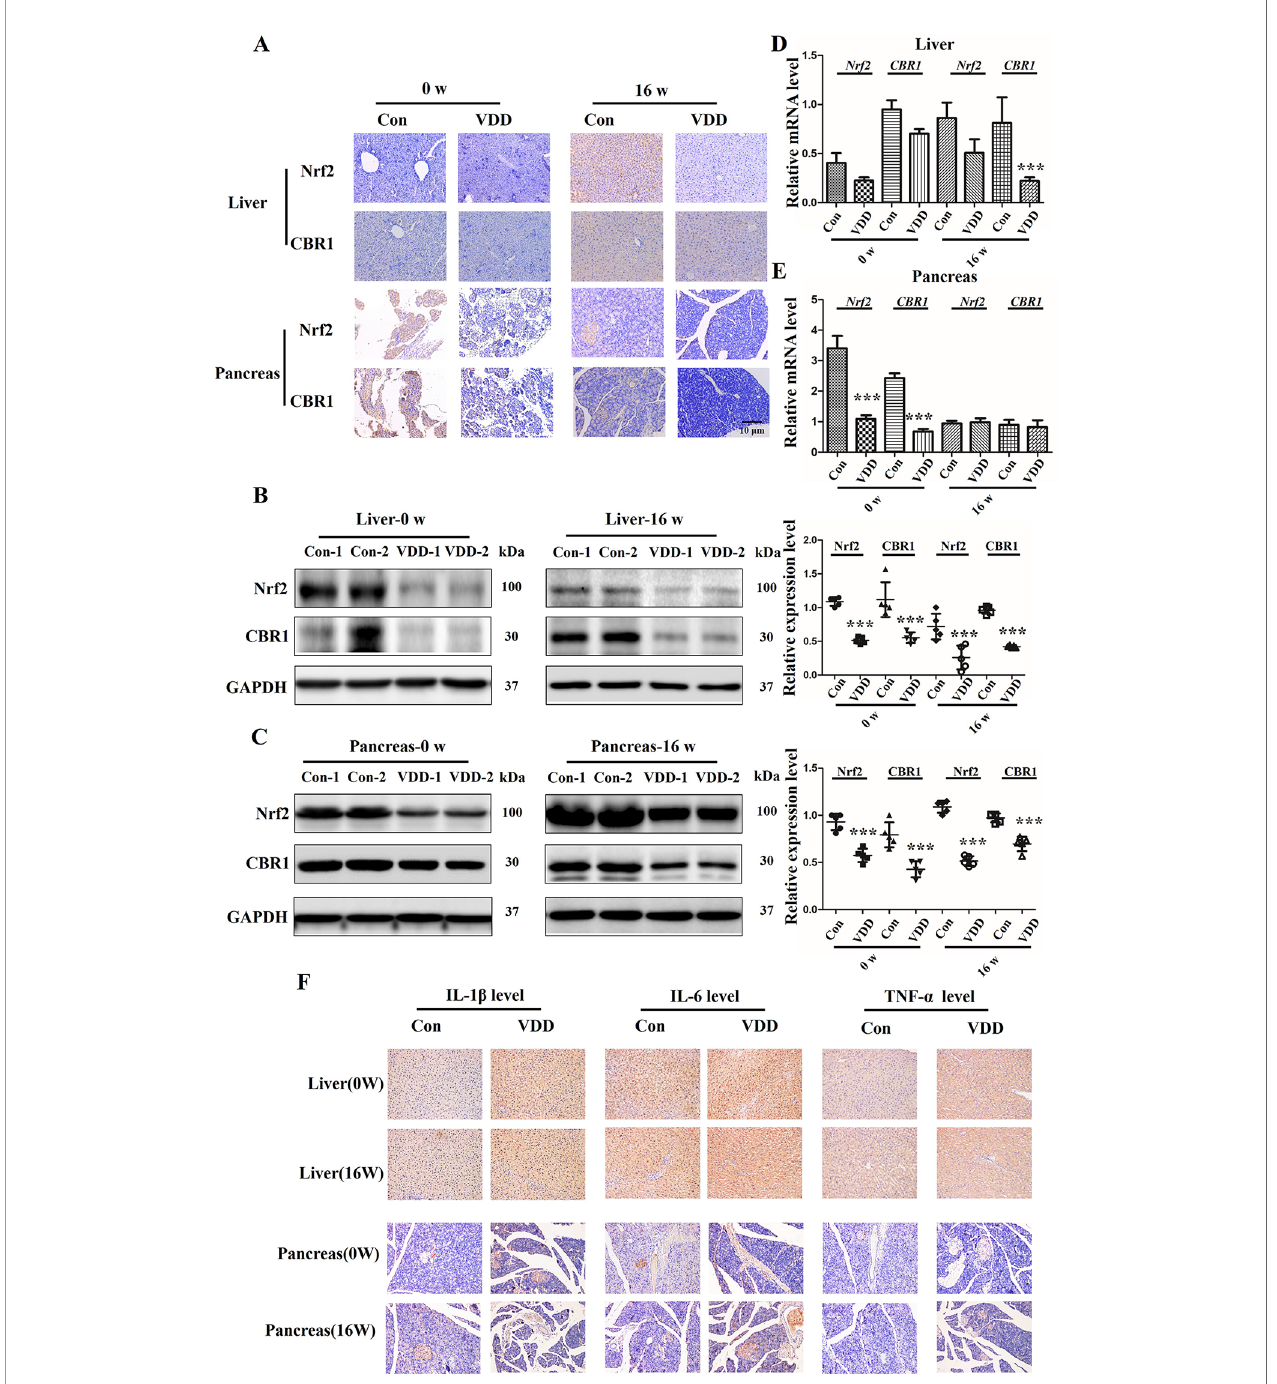
FIGURE 5 | Maternal 25-hydroxyvitamin D de fi ciency altered expression levels of Nrf2, CBR1, and in fl ammatory cytokine in offspring at week 0 and 16. (A) Nrf2 and CBR1 immunohistochemical staining in offspring liver and pancreas tissues obtained in normal group (Con) and 25-hydroxyvitamin D de fi ciency group (VDD) at week 0 and 16 (magni fi cation, ×200). (B , C) Western blotting analysis was used to detect theNrf2 and CBR1 expression level at week 0 and 16 in offspring rat liver (B) and pancreas (C) . Densitometry data for Nrf2 and CBR1 from the blots shown were normalized for analysis to GAPDH, the loading control. (D, E) The Nrf2 and CBR1 levels in offspring liver (D) and pancreas (E) at week 0 and 16 were determined by qRT-PCR. (F) IL-1 b , IL-6and TNF- a IH staining in offspring liver and pancreas tissues obtained in normal group (Con) and 25-hydroxyvitamin D de fi ciency group (VDD) at week 0 and 16 (magni fi cation, ×200). Mean ± SD, n = 5 rats per group. *** P < 0.01, vs. control group. Normal group, Con, Con-1, and Con-2 represent different rats; maternal 25-hydroxyvitamin D de fi ciency group, VDD, VDD- 1, and VDD-2 represent different rats; week,